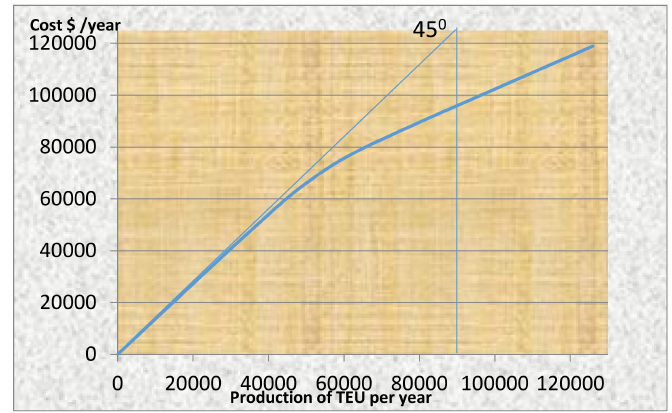
Figure 8. Total cost per year versus total annual production, 1994–2013. Source: Author and excel on numbers from Furuichi and Otsuka